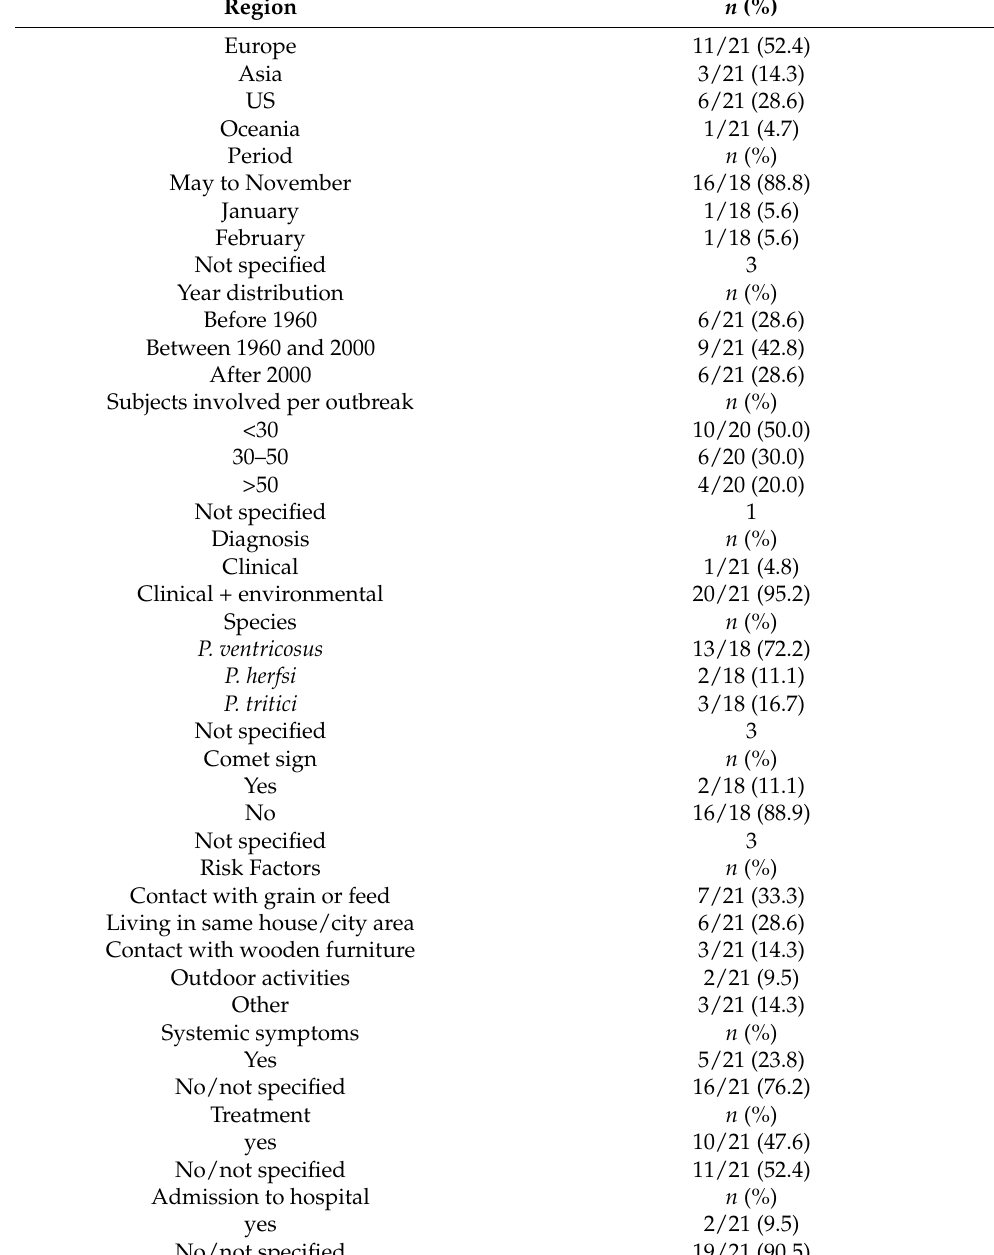
Table 2. Epidemiological and clinical characteristics of